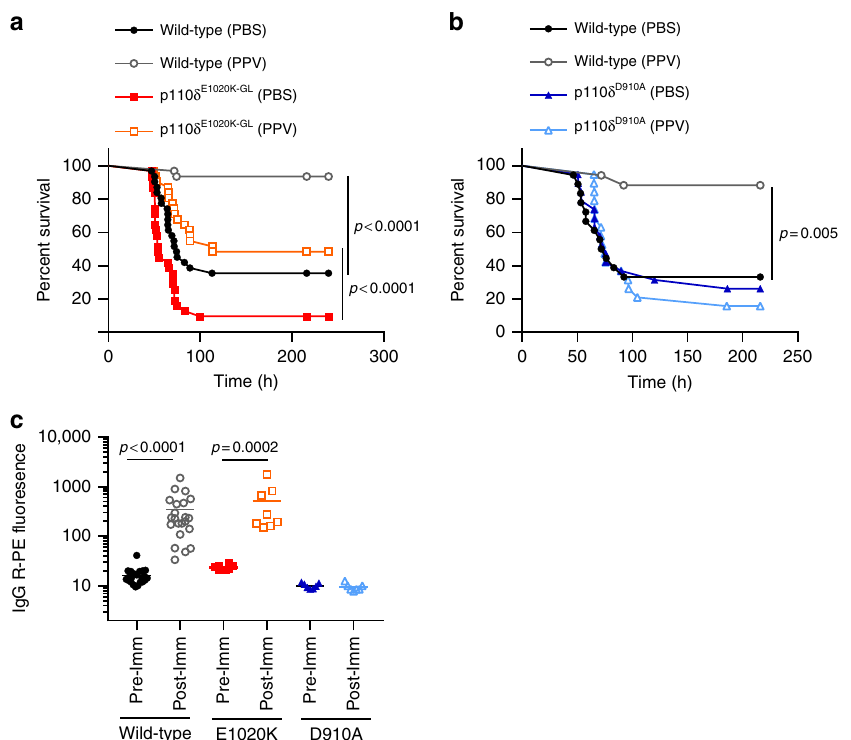
Fig. 5 PI3K δ E1020K-GL mice respond to Pneumovax and have normal antibody levels. a , b Pneumovax (T-independent pneumococcal polysaccharide vaccine, PPV) partially protects p110 δ E1020K-GL mice against infection ( a ), while p110 δ D910A are not protected ( b ). c p110 δ E1020K-GL mice produce normal levels of total IgG in response to Pneumovax immunization (anti-pneumococcal serotype 4 shown) while p110 δ D910A mice do not respond to vaccine. (Data-points represent individual animals; a results from three independent studies combined, n = 30; b results from two independent studies combined, n = 19; c results from two independent studies combined: mean antibody levels shown; WT n = 22; E1020K n = 8; D910A n =